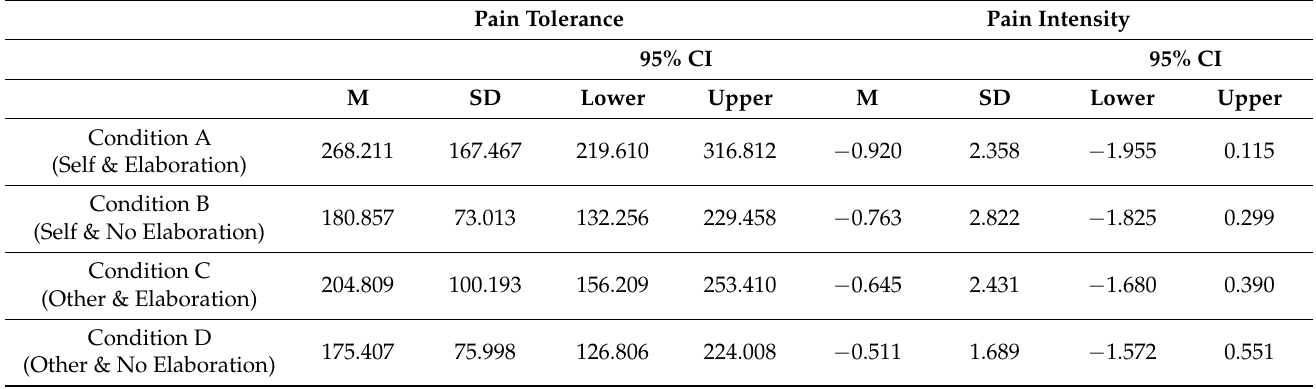
Table 2. Descriptive data for each condition regarding the percentage time tolerating pain at posttest in relation to pretest and pre–post change in pain intensity.